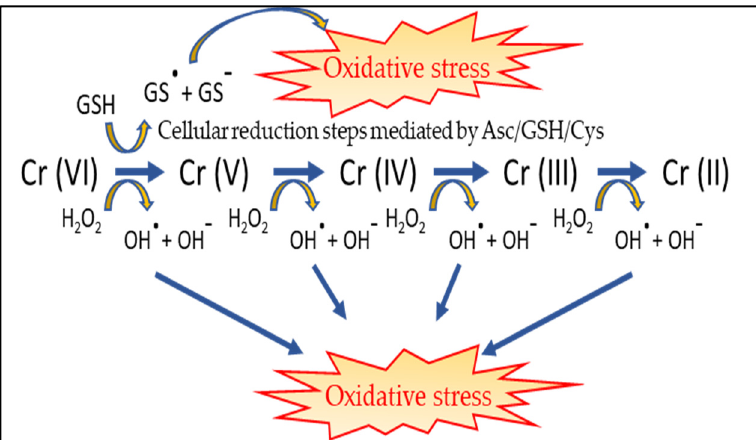
Figure 3. Schematic representation of free radicals formation during Cr (VI) reduction within the cell through Haber–Weiss reactions (modified from [15]). Asc, ascorbate; GSH, reduced glutathione; Cys, cysteine.